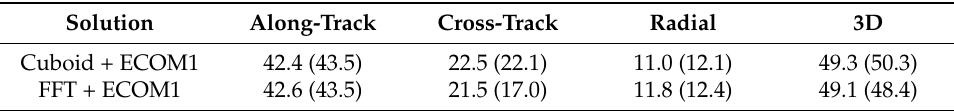
Figure 7. Time series of OBDs for solutions using the a priori ( a ) cuboid model and ( b ) FFT model for BeiDou-3 I2-S. The red, green and blue curves represent OBDs in along-track, cross-track and radial direction, respectively. Table 5. Mean value of OBDs in Along-track, Cross-track, radial, and three-dimensional (3D) for BeiDou-3 I2-S solutions with cuboid and priori model to argument ECOM1. Values in brackets was for eclipse season (unit: cm).